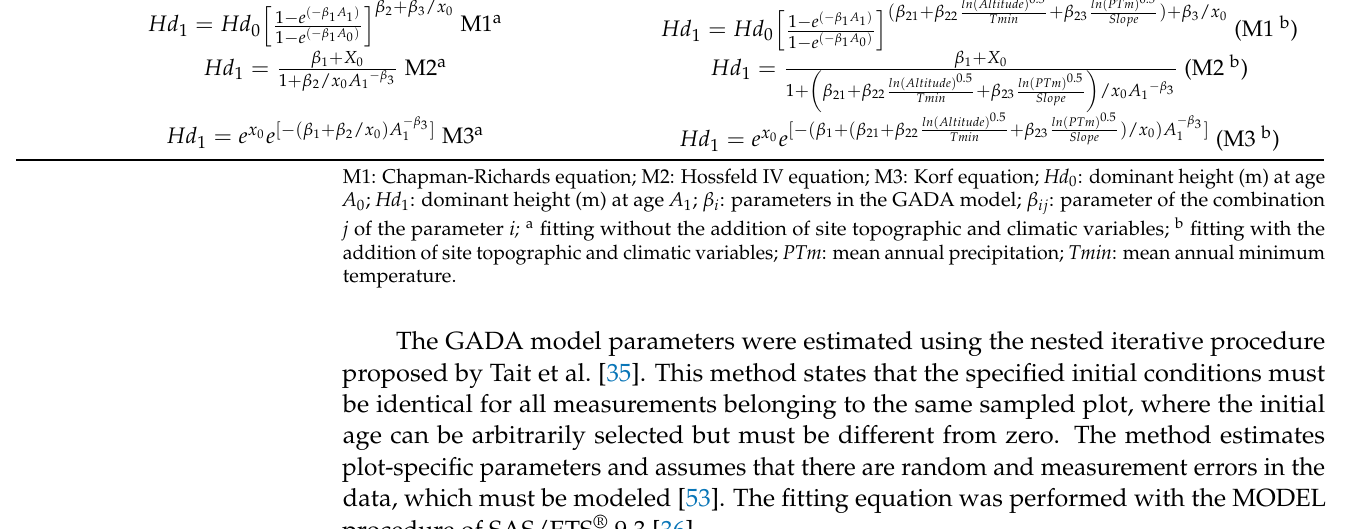
Table 3. GADA formulations with and without site variables fitted to the datasets. GADA Models without Site Variables GADA Models with Site